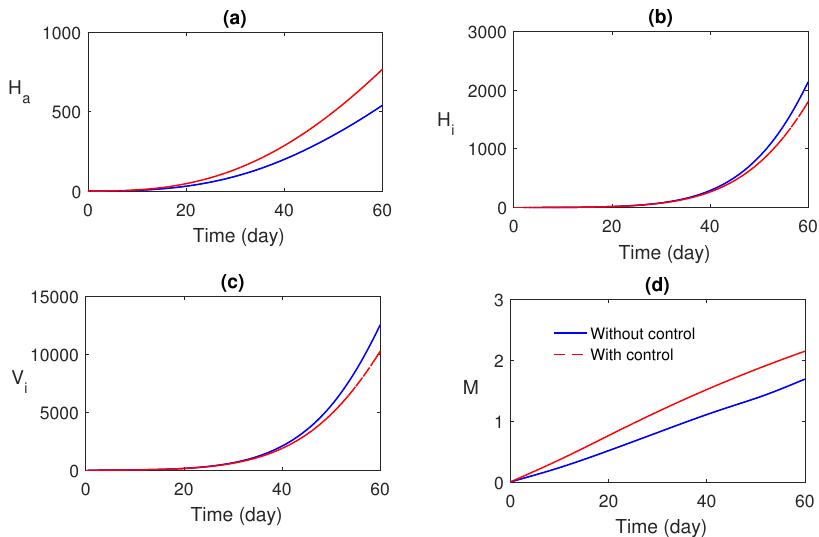
Figure 8. Comparison between the system with and without optimal